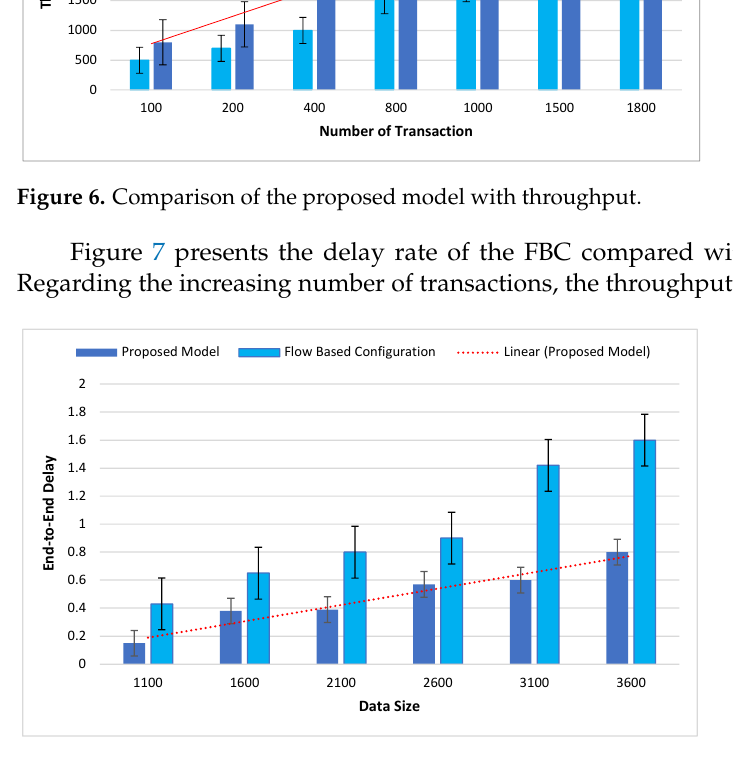
Figure 7. Comparison of the delay in the proposed model with flow-based